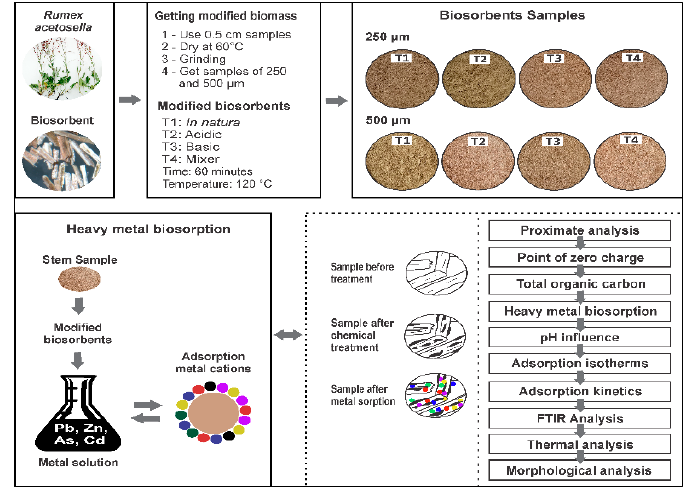
Figure 1. Experimental flow diagram.